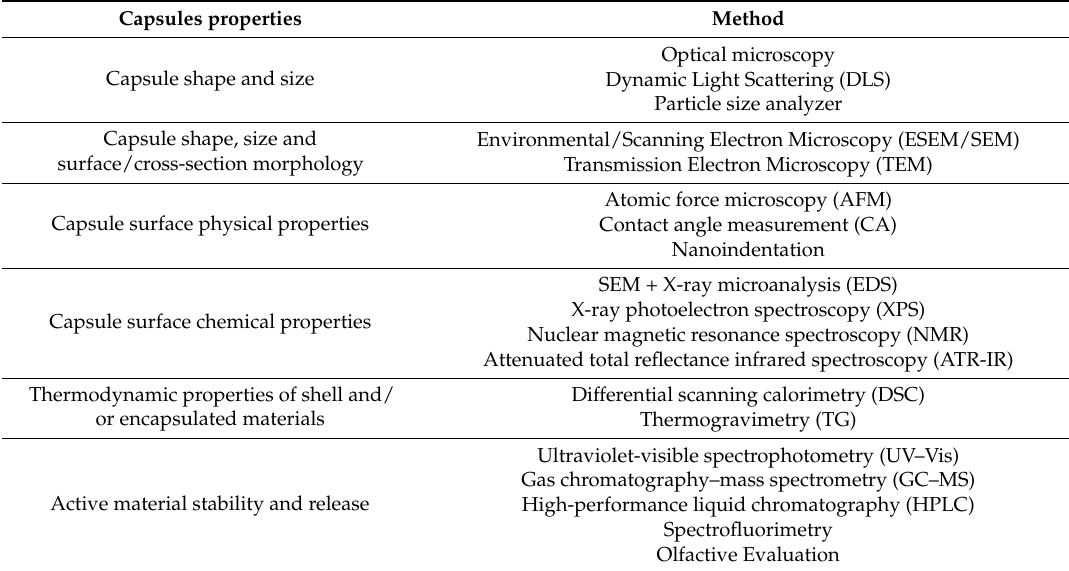
Table 1. Characterization techniques of photo-responsive